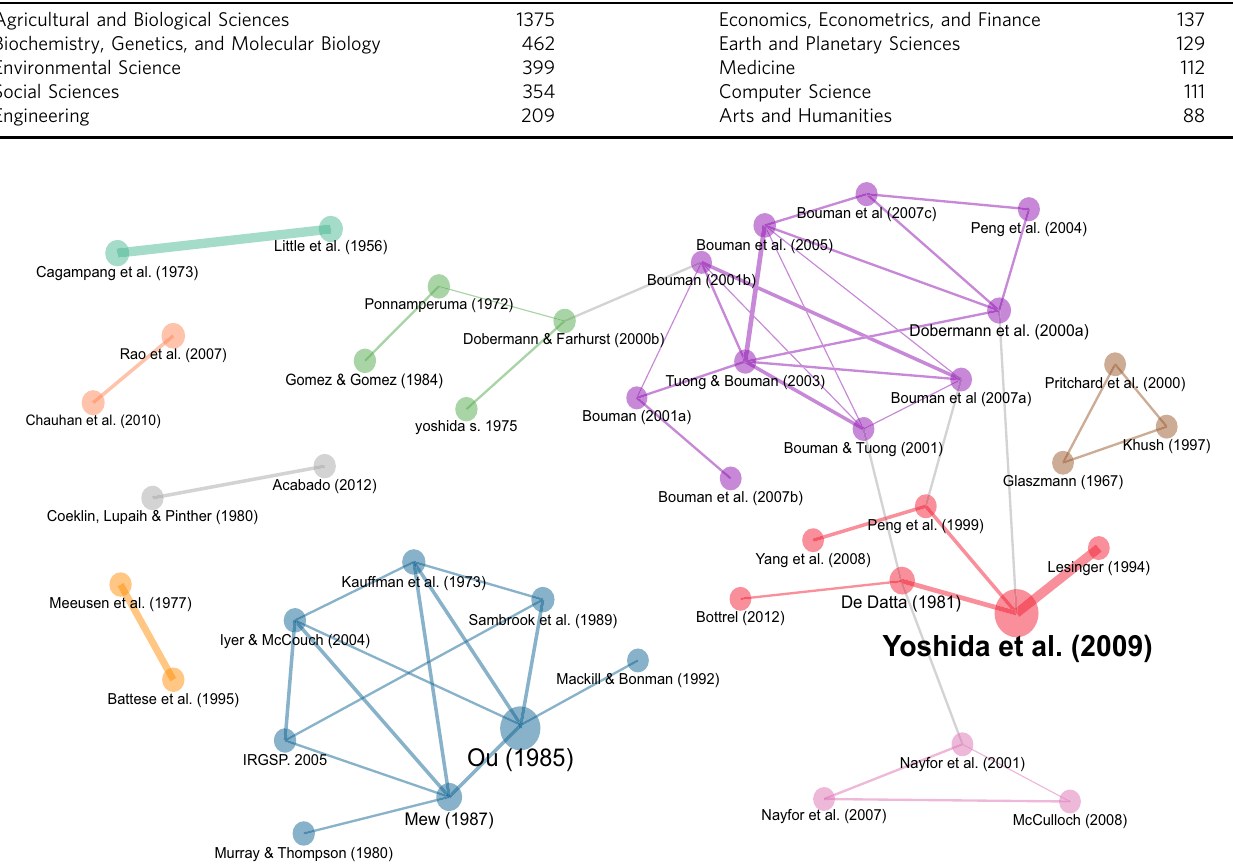
Fig. 9 Article co-citation networks of rice research in Indonesia and the Philippines. There are 10 major networks of rice research co-citations in Indonesia and the